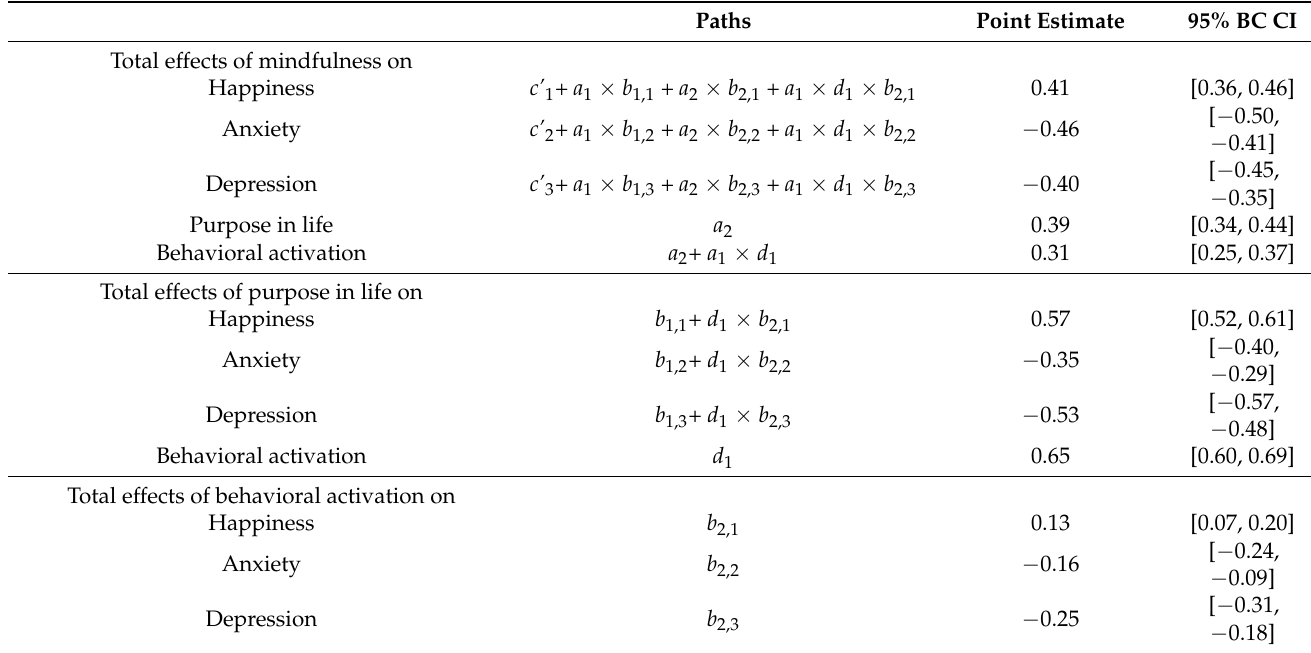
Table 3. Standardized total effects of mindfulness, purpose in life, and behavior activation on mediators and outcome variables.